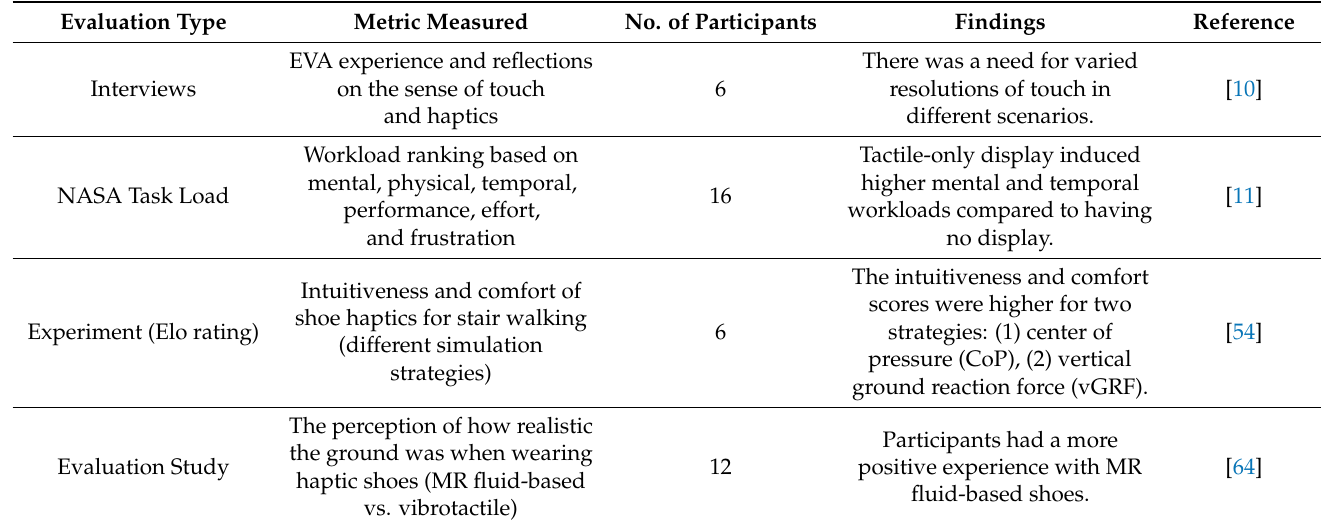
Table 5. An overview of the qualitative evaluation conducted to assess the haptic systems.